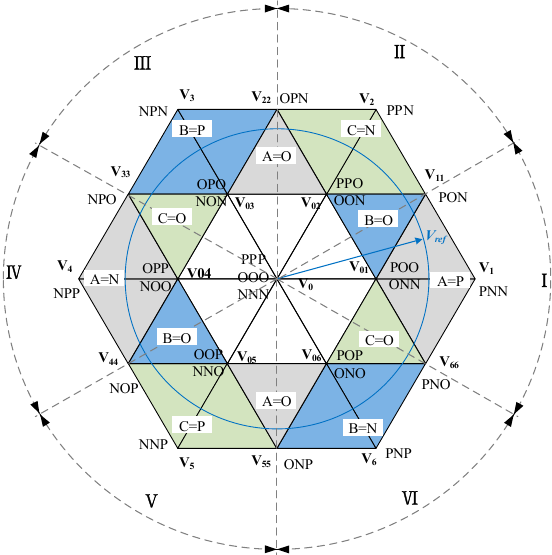
Figure 13. Voltage space vectors for three-level inverter.